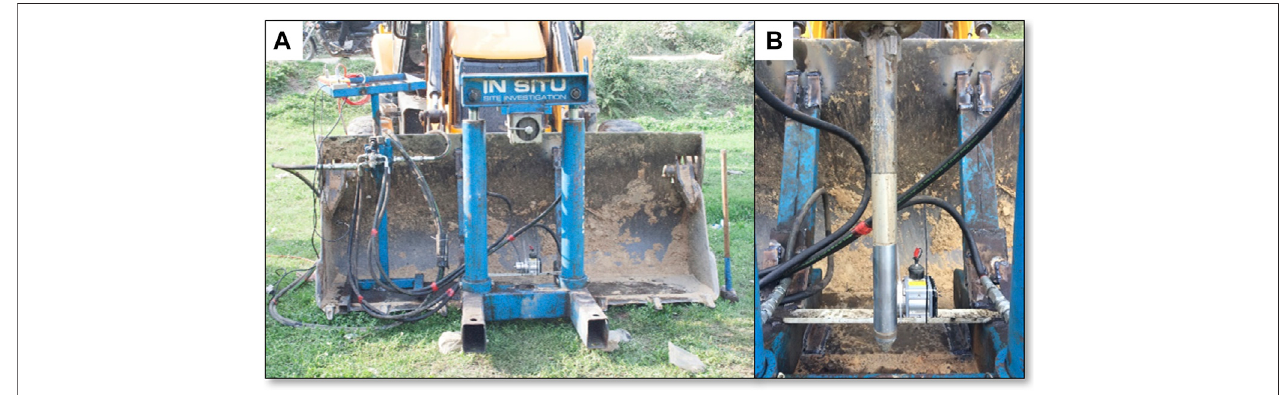
FIGURE 4 | (A) Method of CPT investigation using portable CPT rig which can be welded to hired plant when reaching the country of testing (B) 10 cm 2 cone penetrometer [Photos: C. E. L. Gilder].